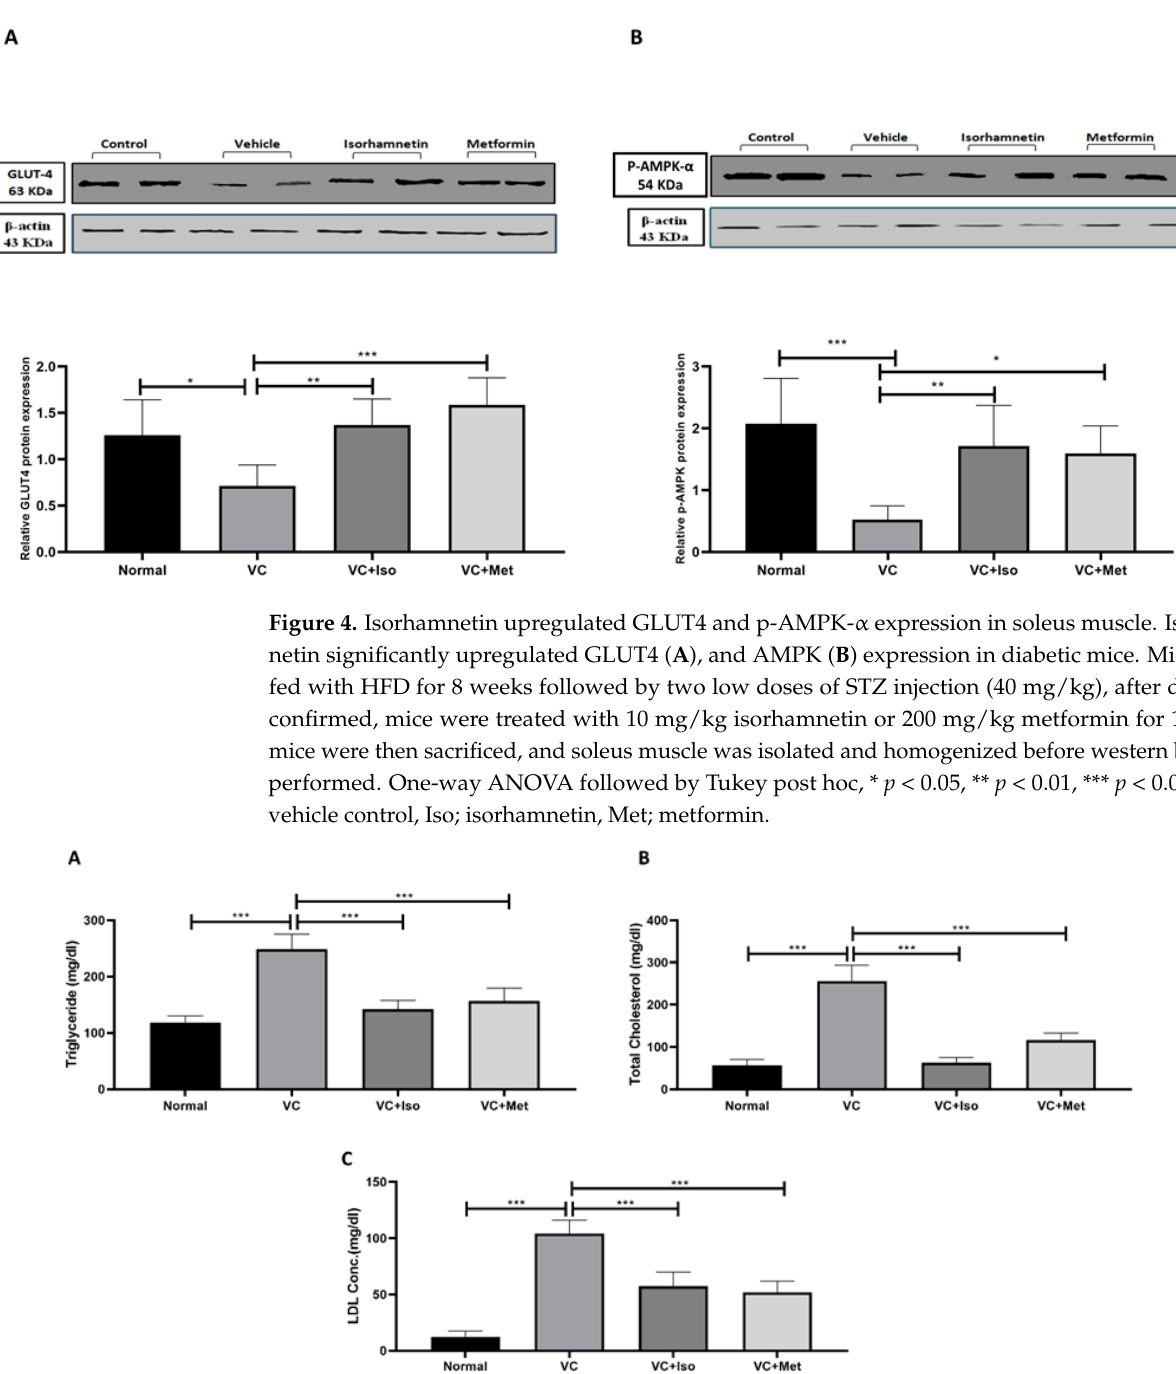
Figure 5. Isorhamnetin improves lipid profile in diabetes. Isorhamnetin significantly reduced triglyceride ( A ), cholesterol ( B ), and LDL ( C ) levels in diabetic mice. Mice were fed with HFD for 8 weeks followed by two low doses of STZ injection (40 mg/kg) after diabetes confirmed, mice were treated with 10 mg/kg isorhamnetin or 200 mg/kg metformin for 10 days, mice were then sacrificed, and serum collected for ELISA analysis. One-way ANOVA followed by Tukey post hoc, *** p < 0.001. VC; vehicle control, Iso; isorhamnetin, Met; metformin.